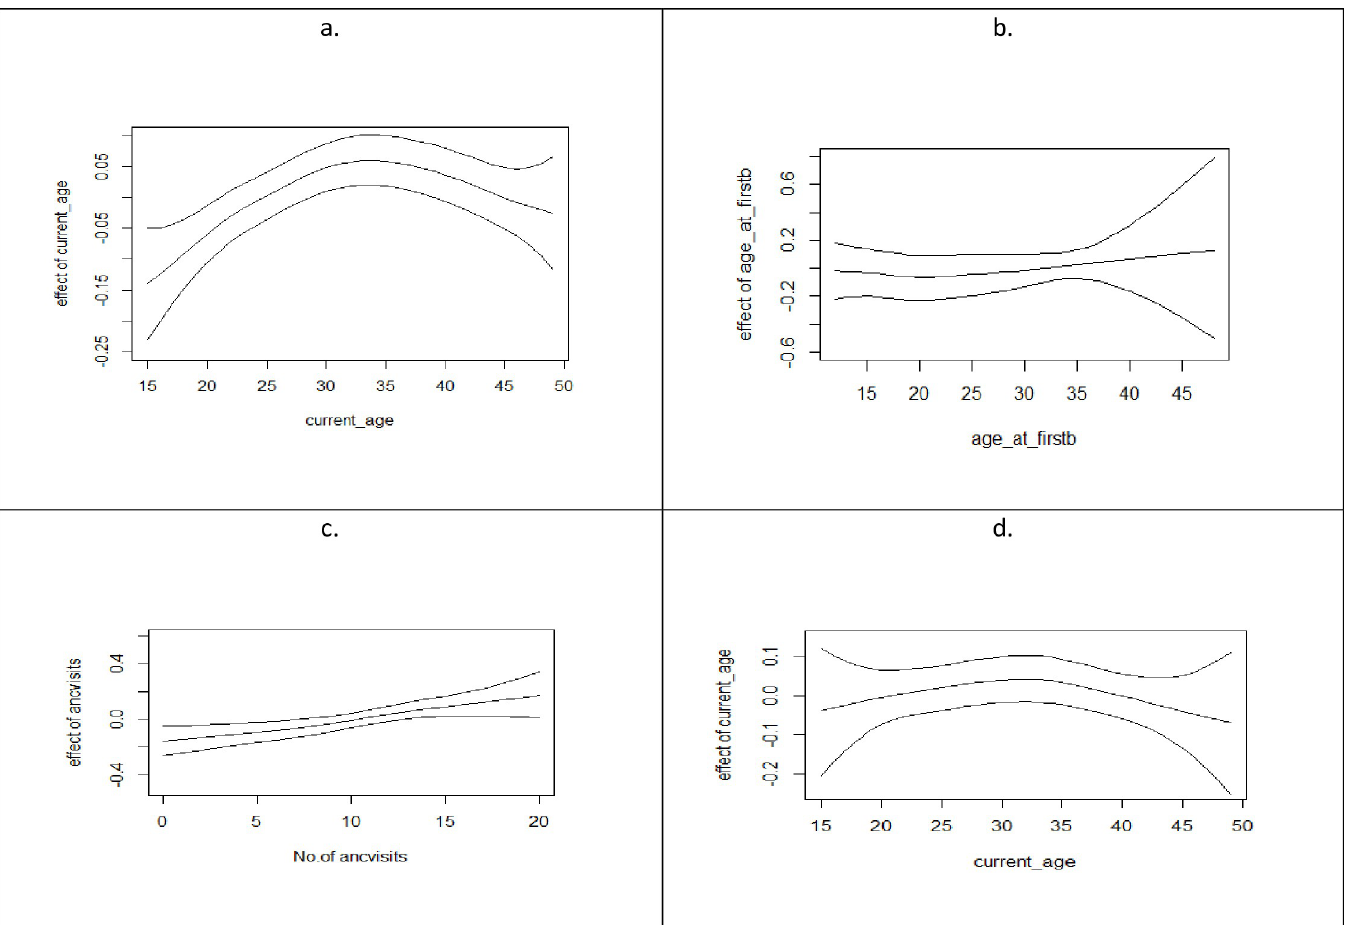
Fig 2. Non-linear effects of (a) woman’s current age at the time of survey, (b) age at first birth, (c) number of antenatal visits, and (d) woman’s current age at the time of survey (ever-married women).